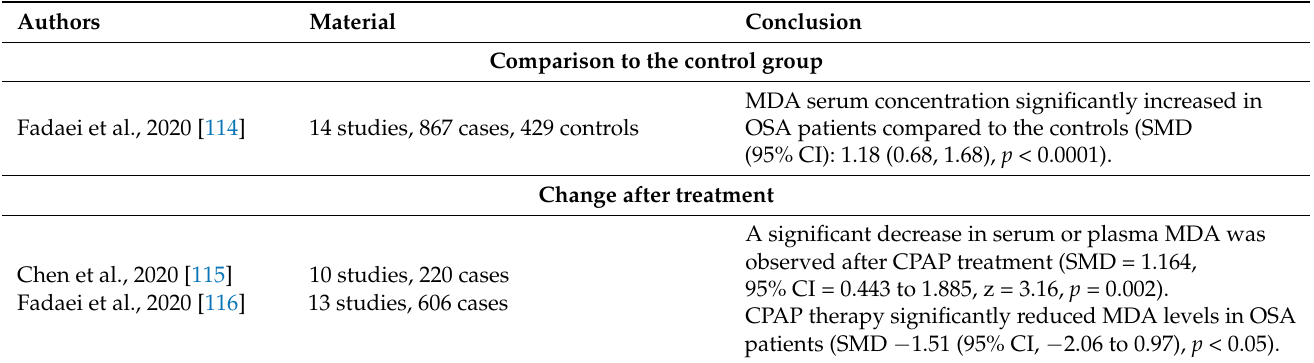
Table 10. Meta-analyses of MDA studies in OSA